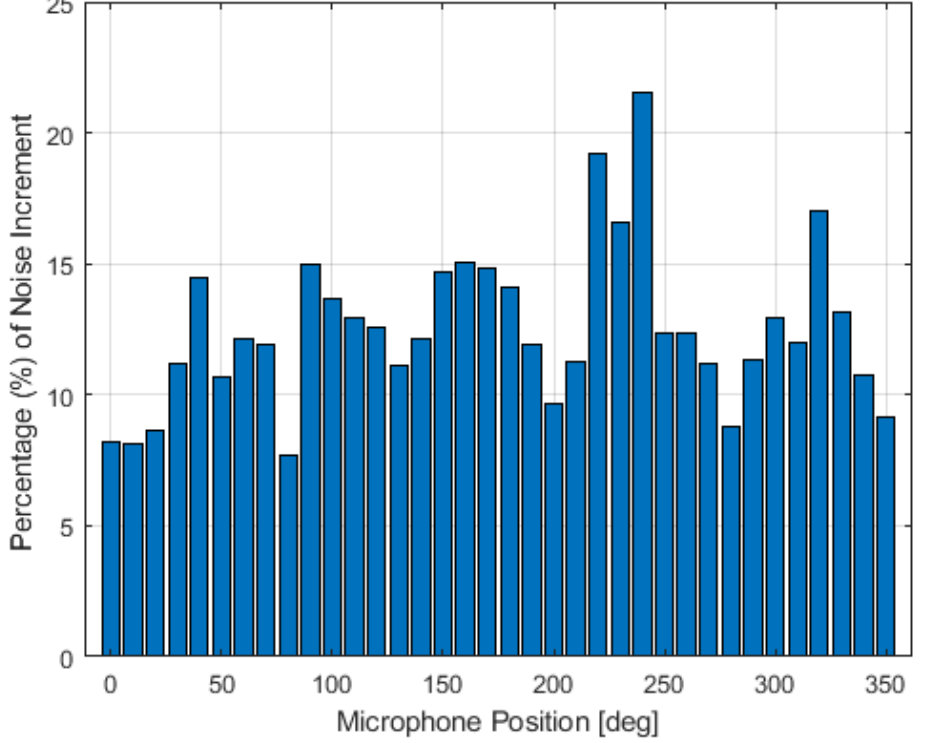
Figure 22. OASPL comparative results between flapped and morphed airfoils, for a set of micro- phones spaced 10 ◦ from each